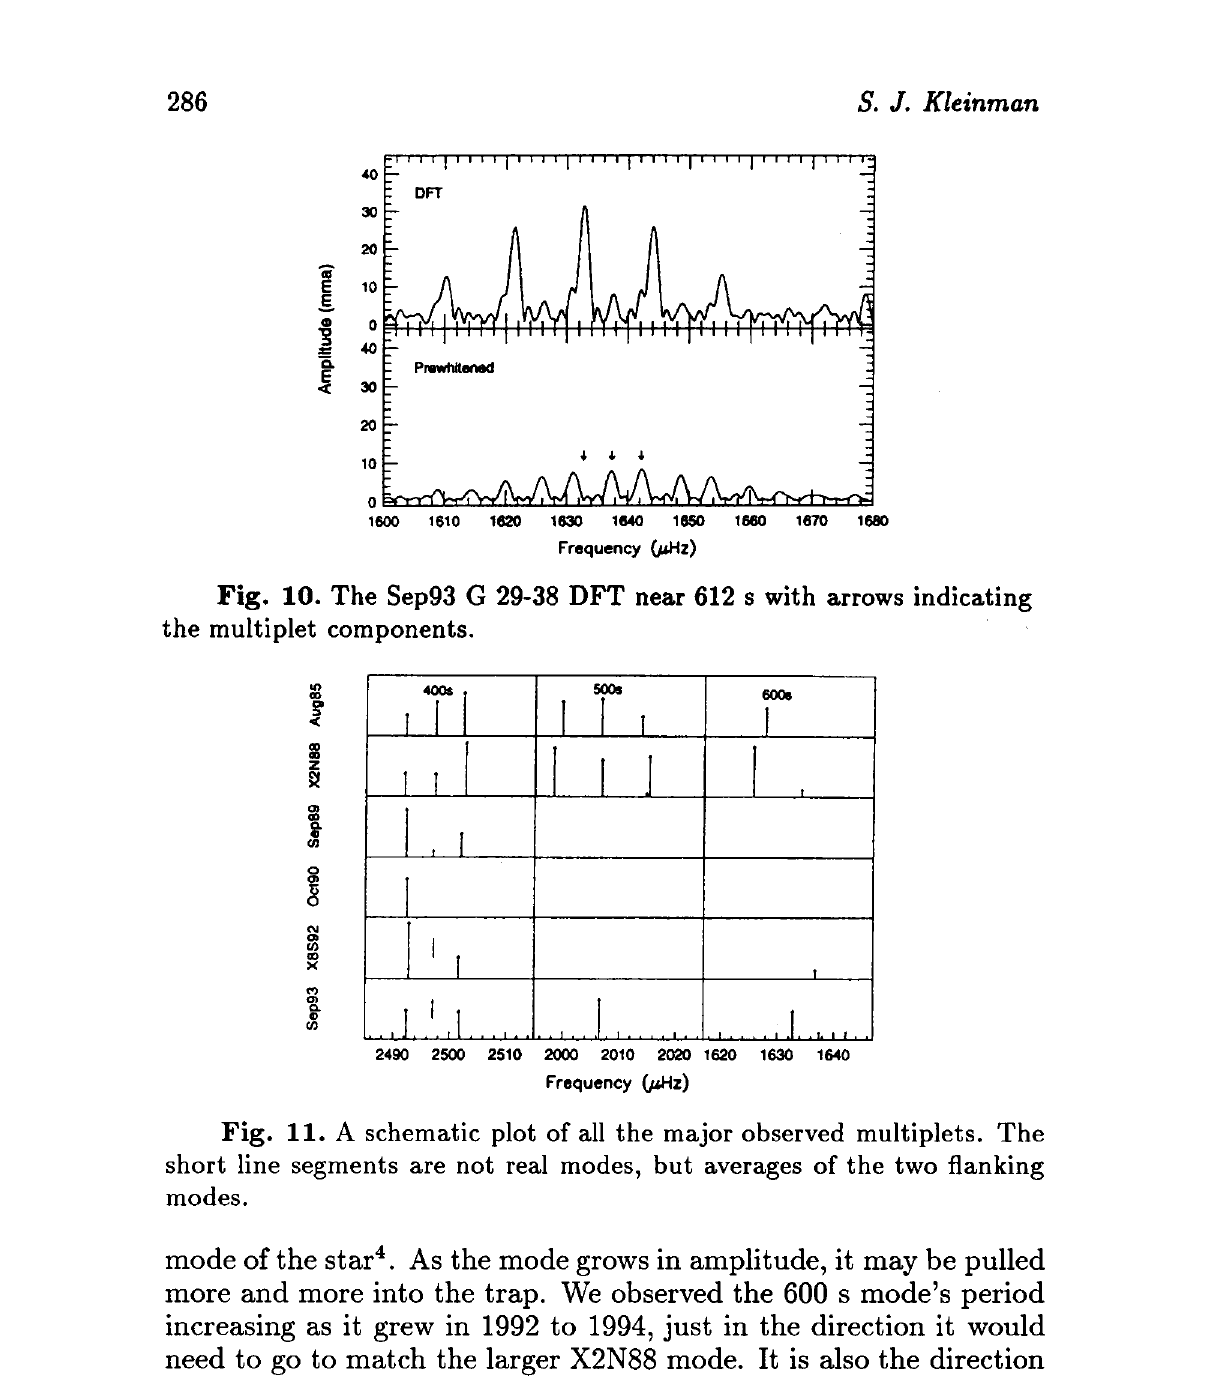
Fig. 11. A schematic plot of all the major observed multiplets. The short line segments are not real modes, but averages of the two flanking